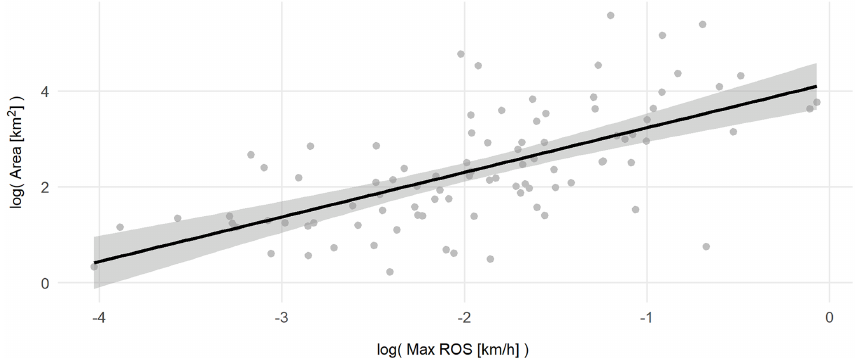
Figure 6. Linear regression model for log-transformed variables (maximum ROS and burned area), indicating a positive relationship between maximum ROS and final burned area for each